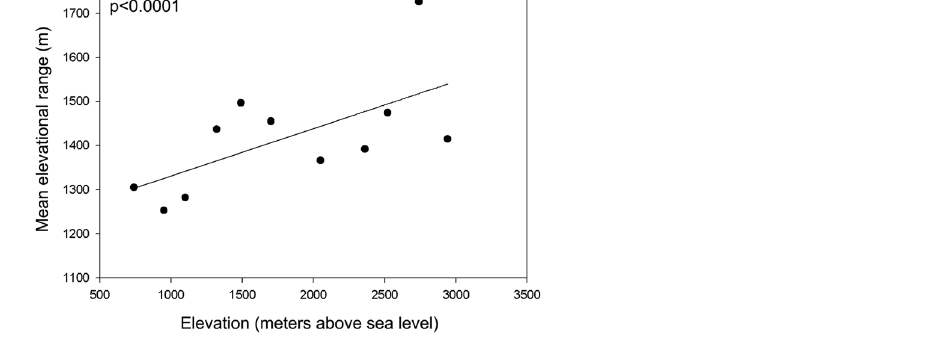
Figure 8. The mean elevational range of high elevation nematodes have broader elevational ranges and therefore broader temperature ranges. High correlations (p < 0.01) were found at all sequence similarities. MAT, mean annual